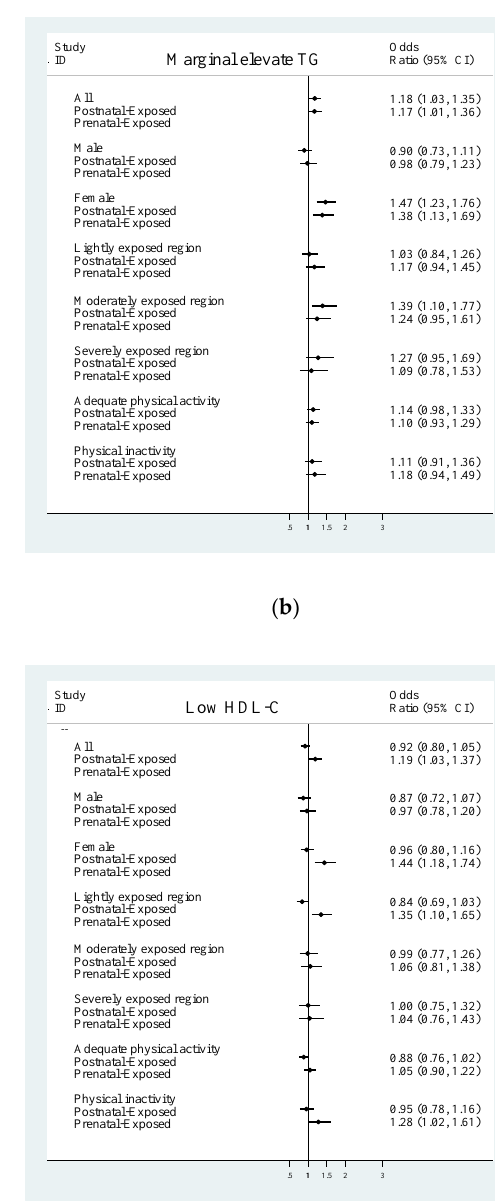
Male Postnatal-Exposed Prenatal-Exposed Female Postnatal-Exposed Prenatal-Exposed Lightly exposed region Postnatal-Exposed Prenatal-Exposed Moderately exposed region Postnatal-Exposed Prenatal-Exposed Severely exposed region Postnatal-Exposed Prenatal-Exposed Adequate physical activity Postnatal-Exposed Prenatal-Exposed Physical inactivity Postnatal-Exposed Prenatal-Exposed